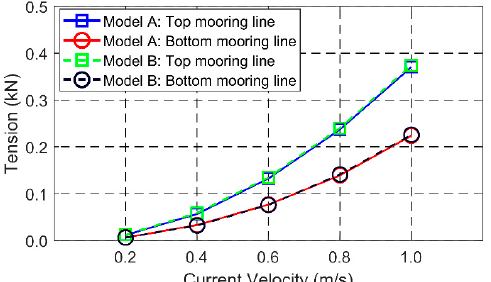
Figure 4. Envelopes of vertical motions (net-top motion minus net-bottom motion) of Model A and Model B at a current velocity of 0.6 m/s for the convergence test.